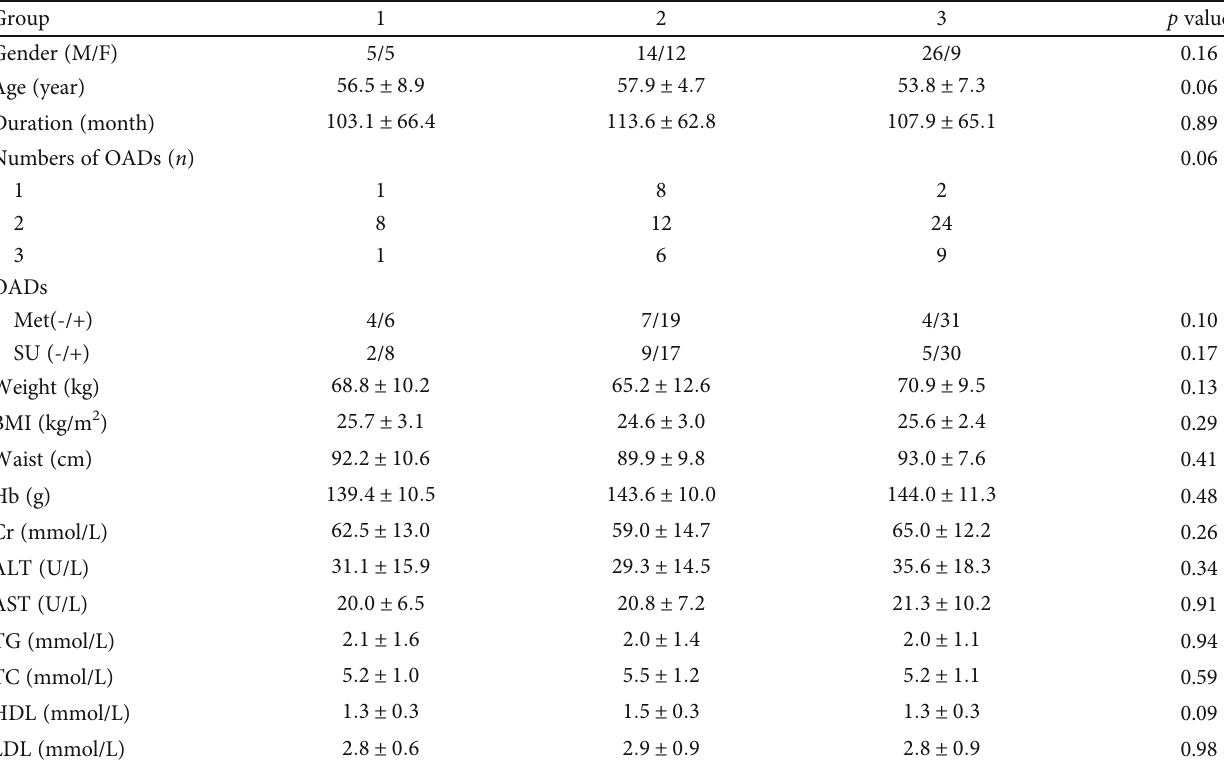
Figure 2: A total of 71 patients fi nished the study. Table 2: The baseline characteristics of subjects among the three groups.